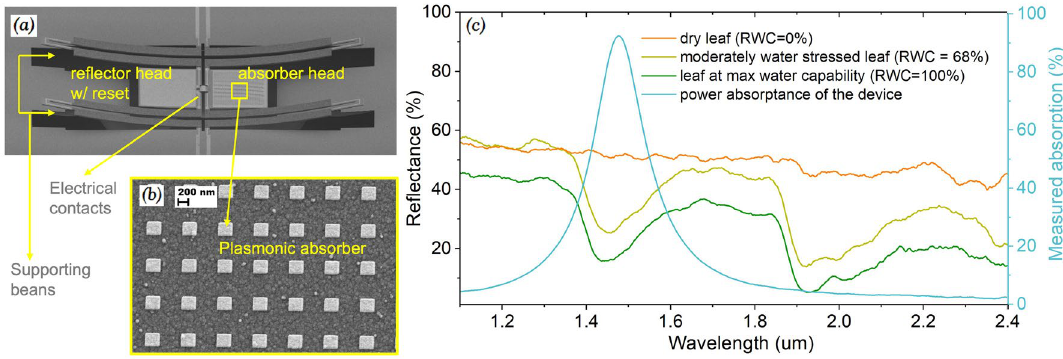
Figure 2. ( a ) Scanning electron microscope (SEM) image of the fabricated PMP. The right cantilever has a SWIR plasmonic absorber while the left one reflects IR and has an in-built microheater for reset. The contacts of the PMP are located in the middle. ( b ) Close-up of the absorber surface. The lateral dimensions of the metal patches determine absorption wavelength. ( c ) Fourier Transform-IR (FTIR) spectrometer measurement of the absorptance spectrum of the fabricated device and of the reflectance spectra of dry (RWC = 0%), visually moderately water stressed (RWC = 68%) and non-stressed (RWC = 100%) leaves. Absorption peak of the device matches well with the water absorption valley region of the leaf’s reflectance